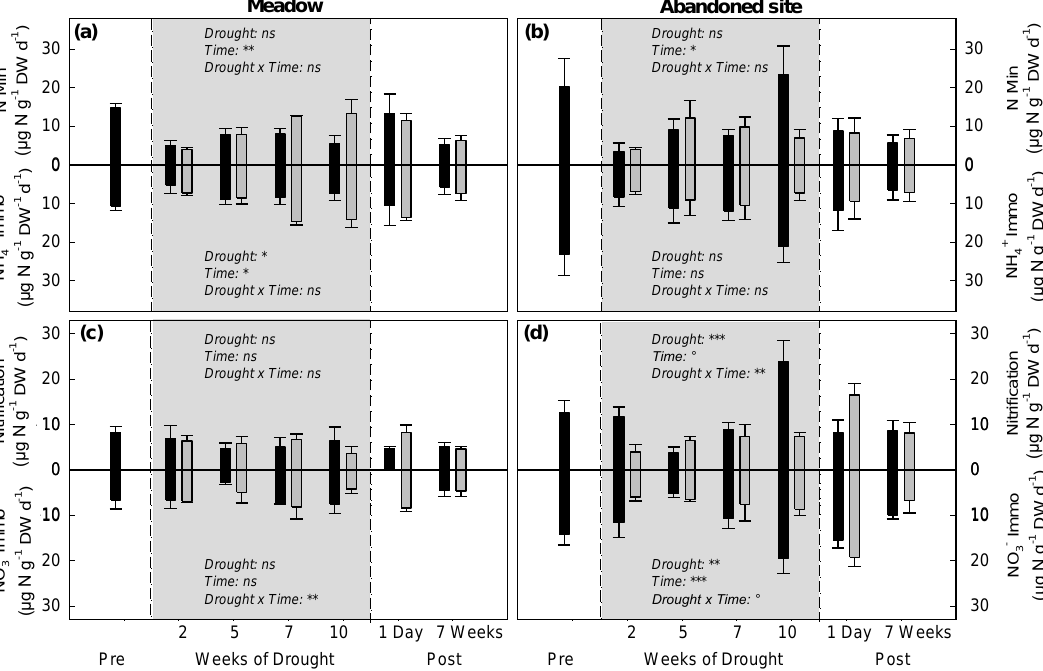
Figure 4. N transformation rates over the course of the experiment at the meadow (left panel) and the abandoned site (right panel) in control (black bars) and drought-treated plots (grey bars). (a, b) Gross N mineralization (upper part) and gross microbial NH + rates (lower part); (c, d) gross nitrification (upper part) and gross microbial NO − indicates the period of drought treatment. Differences between control and drought-treated plots at single sampling points assessed by t - tests with Bonferroni-corrected levels of significance ( n = 4; error bars indicate standard error). Effects of drought and sampling time were assessed by two-way repeated-measures ANOVA; for further details see Table